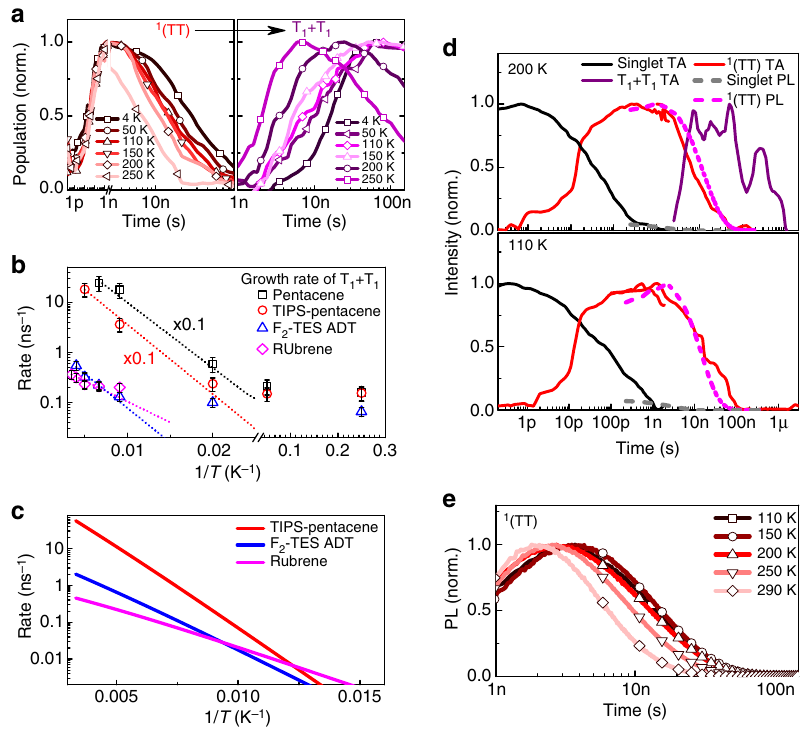
Figure 7 | 1 (TT) decay through activated triplet hopping. ( a ) Kinetics of 1 (TT) and free triplet species in F 2 -TES ADT films, extracted from TA measurements over the temperature range 4–250K and revealing temperature-dependent conversion. Kinetics presented on separate time axes for clarity. ( b ) Rate of 1 (TT) decay as a function of temperature. Error bars are uncertainty in the exponential fitting of 1 (TT) decay. Dashed lines are mono-exponential fits to the high-temperature data. Although the overall rate of 1 (TT) separation varies widely, the temperature dependence is strikingly similar across the series (activation energy B 20–40meV). Data for pentacene-based materials scaled by 0.1 (cid:2) for clarity. ( c ) Marcus–Levich–Jortner rate model of 1 (TT) separation for three p -stacked systems. The strong variation in rate is attributed to the triplet-transfer coupling, while the temperature dependence is primarily governed by the enthalpy of 1 (TT) separation. ( d ) Normalized population kinetics of excited-state species extracted from TA measurements (solid) and PL measurements (dashed) of F 2 -ADTsingle crystal at 200 and 110K (see also Supplementary Fig. 21). As in thin films, sequential conversion from S 1 to emissive 1 (TT) to free triplets is observed, but 1 (TT) separation is fully suppressed at low temperature. ( e ) Normalized, temperature-dependent decay kinetics of 1 (TT) in F 2 -ADTsingle crystal. At low temperature where no free triplets are formed, the decay converges to the intrinsic 1 (TT) lifetime. Table 2 | Parameters for triplet hopping model from ab initio calculations. V T (cid:3) T (meV)